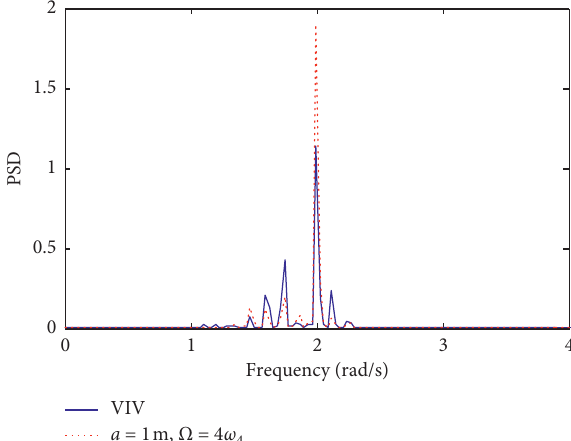
Figure 5: Frequency spectrum of TTR ( U